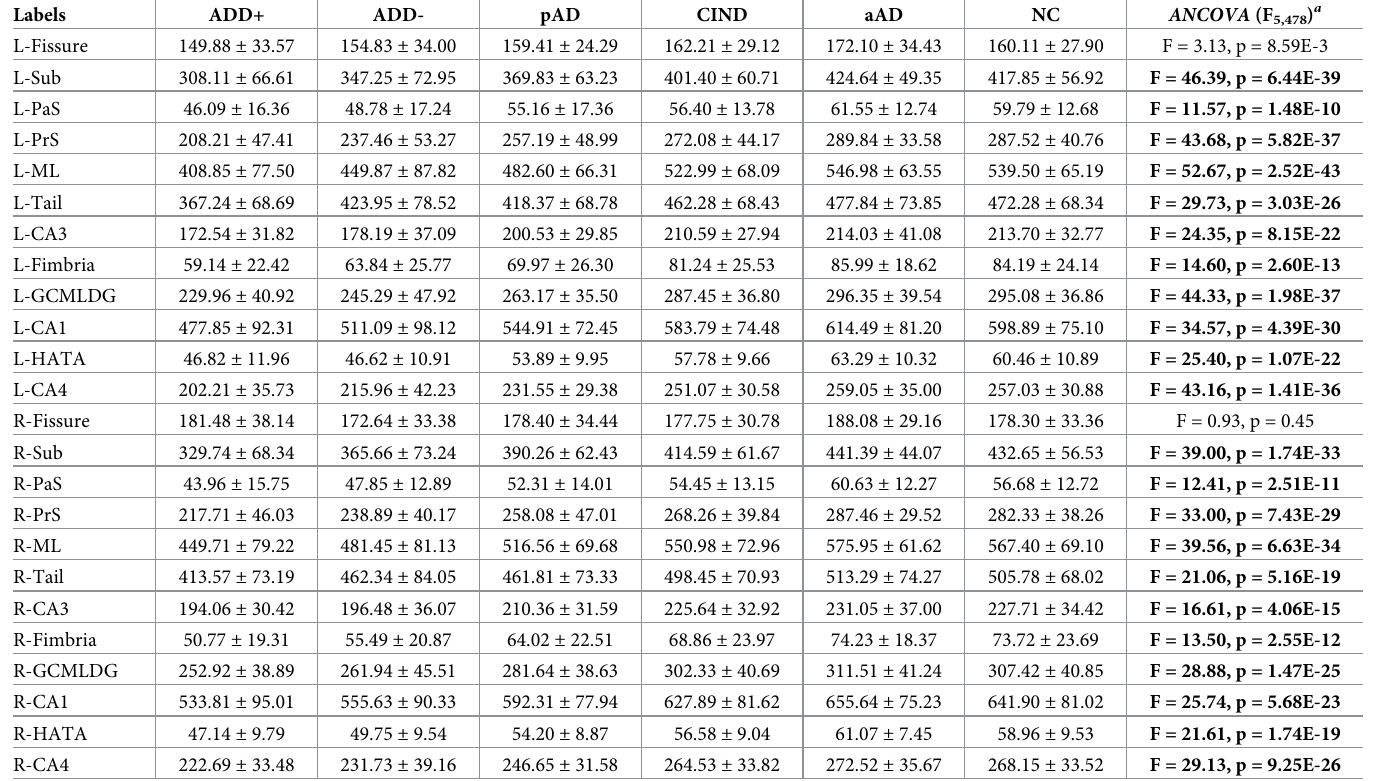
Table 2. Volume (mm 3 ) of left and right hippocampal